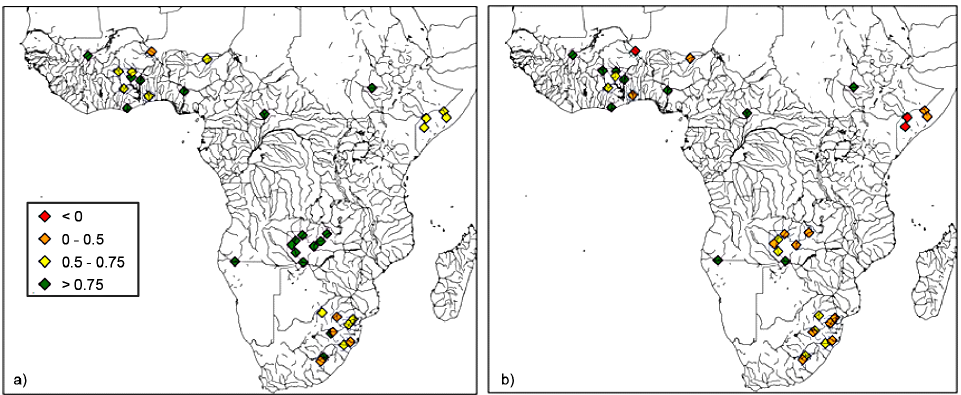
Figure 5. Modified Kling–Gupta Efficiencies between daily LISFLOOD simulated and observed discharge for (a) the calibration period 2004–2008 and (b) the validation period 1998–2003.